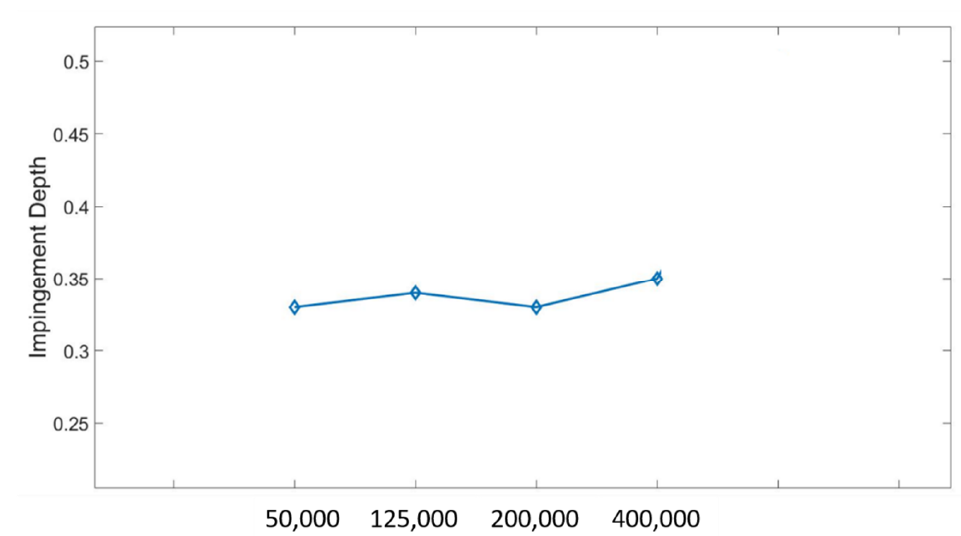
Figure 4. Velocity magnitude as a function of the mesh size.